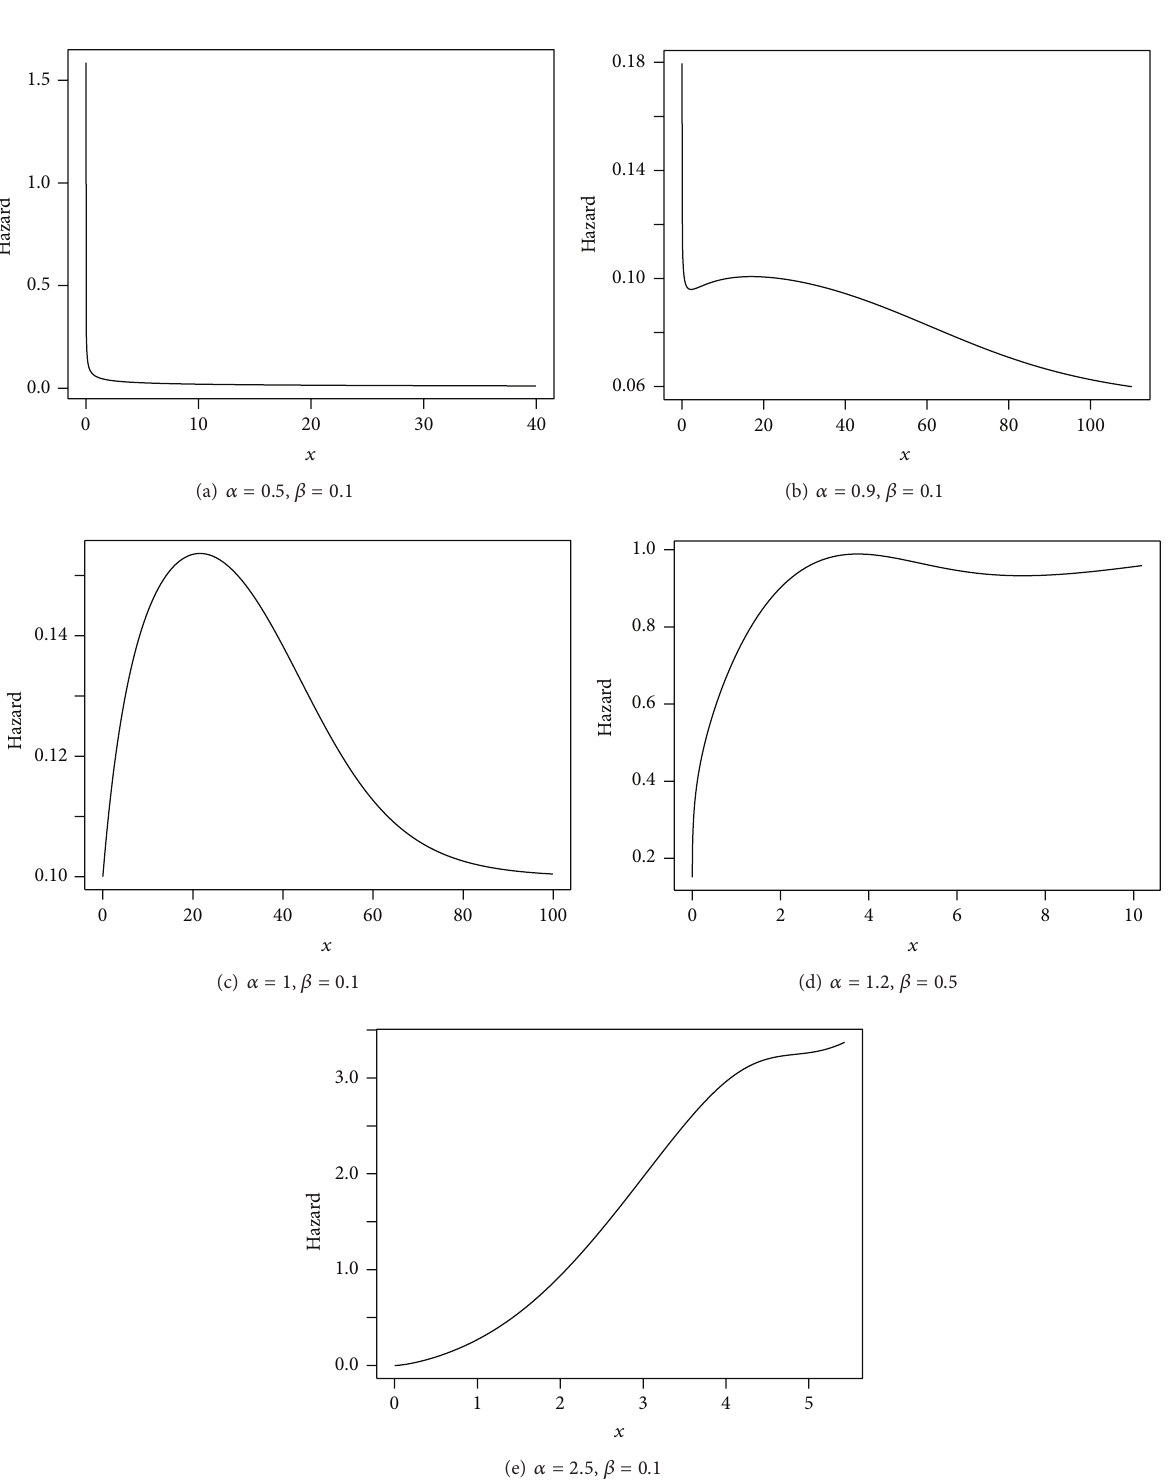
Figure 4: The hazard function of TN (𝛼,𝛽) for some parameter